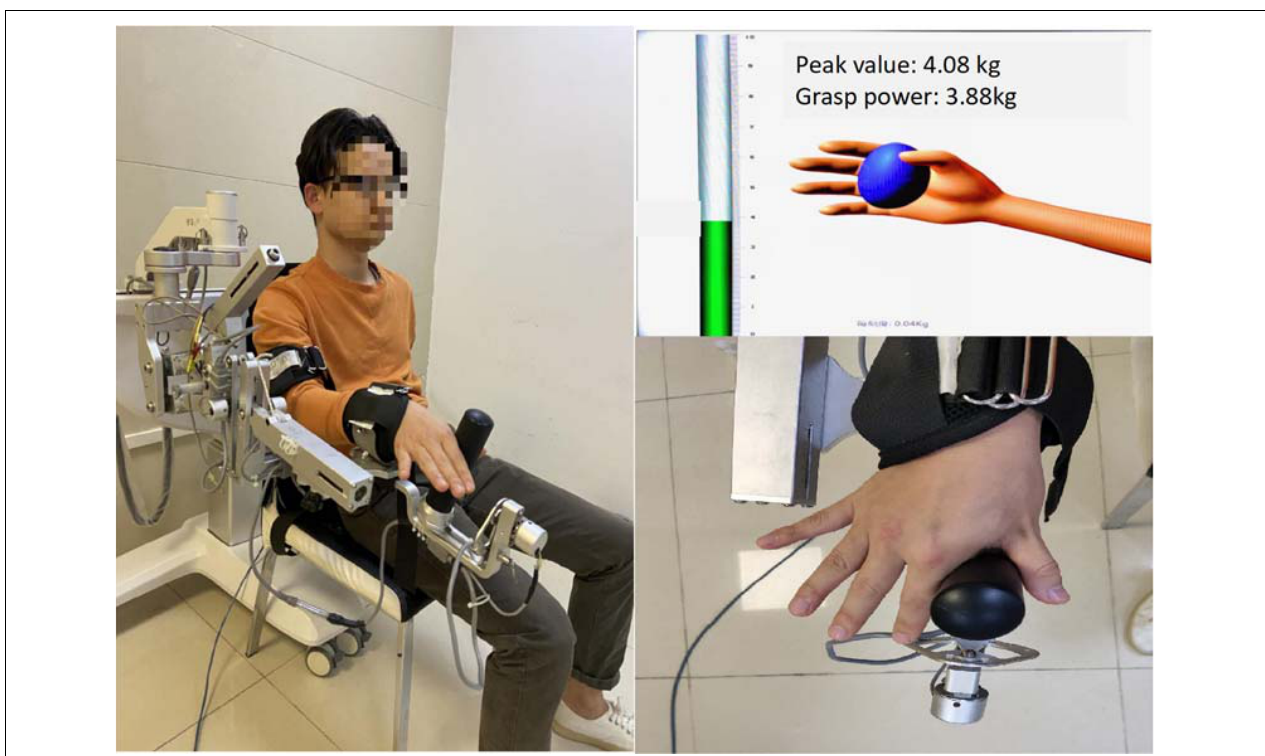
FIGURE 2 | The SVIPT program. Participants were seated with the left shoulder and elbow flexed and the forearm in a neutral position and fixed on the upper limb exoskeleton of the intelligent feedback training system (IFTS). The radial side of the index finger and thumb was tightly attached to the columnar sensor. Participants learned to control column pressure to reach the target number